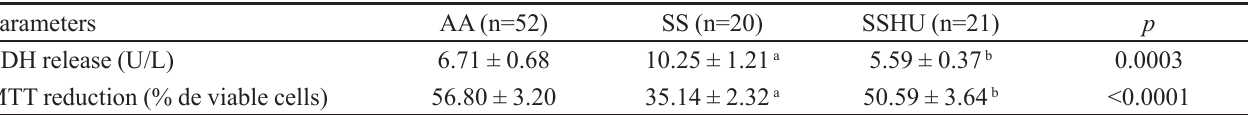
AA: Control group (healthy individuals), SS: patients with sickle cell anaemia not treated with HU; SSHU: patients with sickle cell anaemia treated with HU. Results were expressed asmean ± SEM. ANOVA followed by Tukeypost test. a p<0.05 versus AA group, b p<0.05 versus SS group TABLE IV - LDH release, MTT reduction and DNA damage according to length of HU treatment and mean HU dose (SSHU group) (n=21)